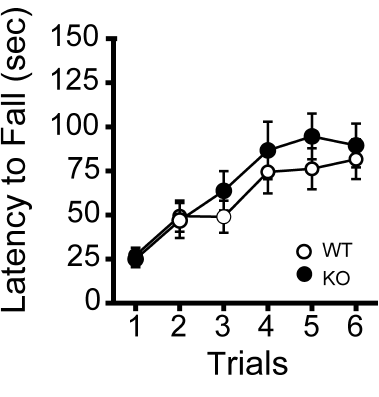
respectively.Figure 4 | Normal motor coordination/learning of kf-1 + / + and kf-1 − / − mice in the rotarod test. The kf-1 + / + and kf-1 − / − mice were tested on an accel- erating rotarod and no signifi cant differences were found between the two = 0.441) (see Section ‘Rotarod test’). WT and KO genotypes ( p = 0.5108, F 1,38 stand for kf-1 + / + and kf-1 − / − mice,